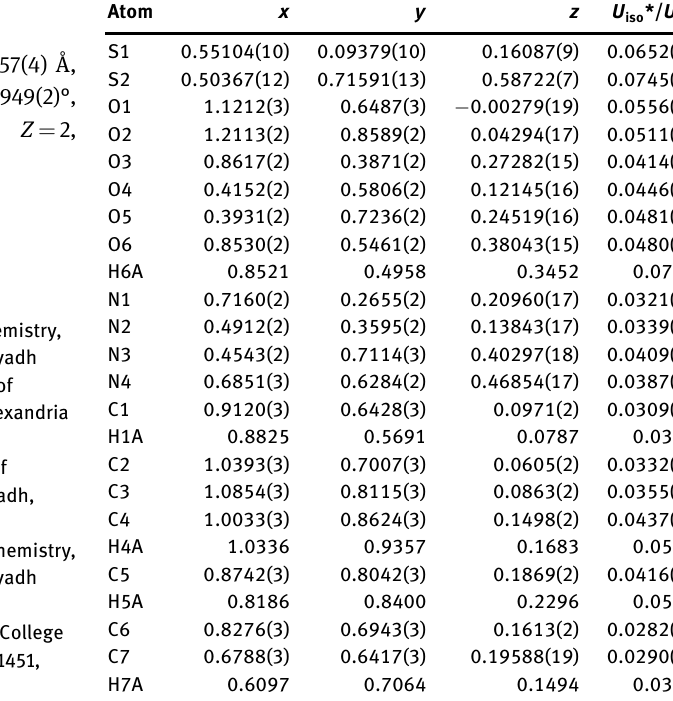
Table 2: Fractional atomic coordinates and isotropic or equivalent isotropic displacement parameters (Å 2